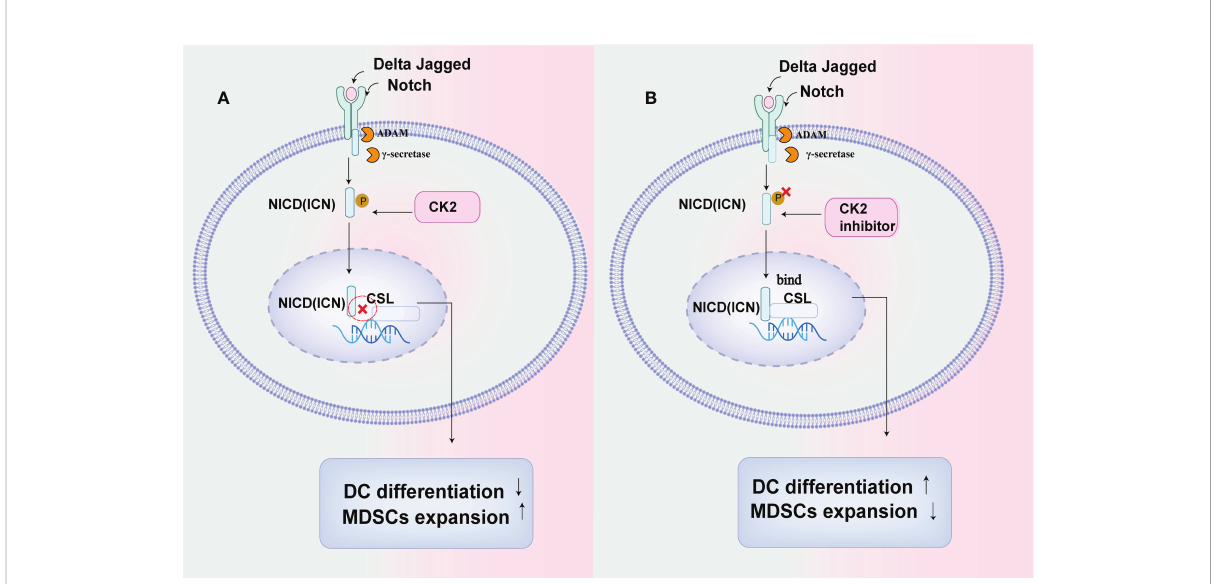
FIGURE 1 CK2 can affect the differentiation of myeloid cells by down-regulating the Notch signal pathway. (A) CK2 can phosphorylate the Notch receptor NICD (Notch intracellular domain)and decrease the binding of NICD to transcriptional repressor CSL, resulting in reduced notch signal transcriptional activity, which will lead to the defective DC cells differentiation while increasing the accumulation of immunosuppressive cells including PMN-MDSC and tumor-associated macrophages (TAMs) in tumors. (B) CK2 inhibitor can restore the activation of Notch signal in myeloid cells and promote NICD to combine with CSL to enhance DC cells differentiation while reducing the production of PMN-MDSCs and tumor-associated macrophages (TAMs) by blocking their